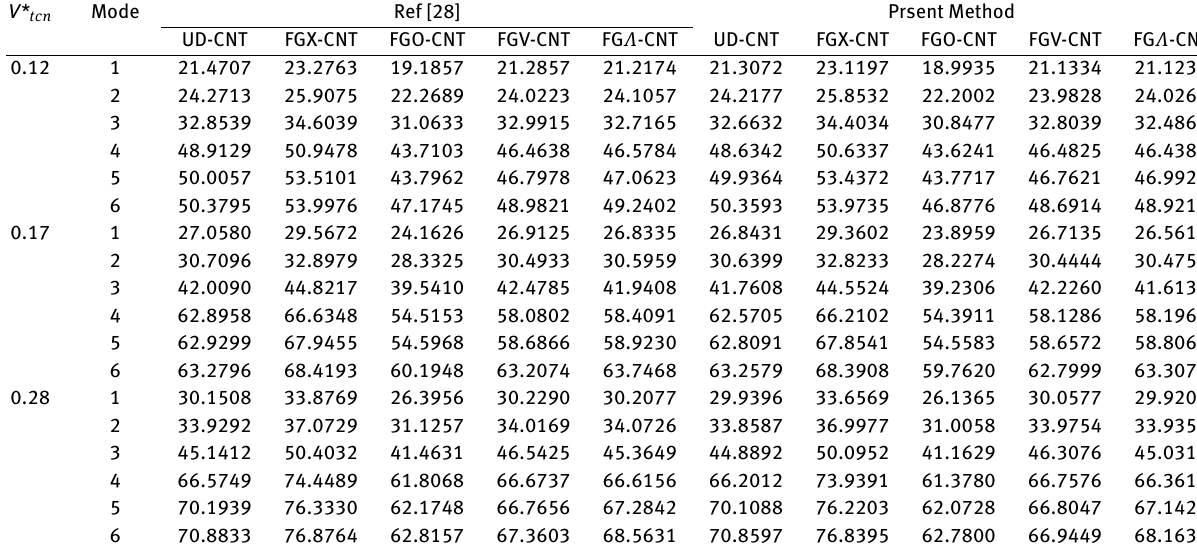
Table 3: Comparison of the frequency parameters Ω for a FG-CNT reinforced composite panel with SSSS boundary